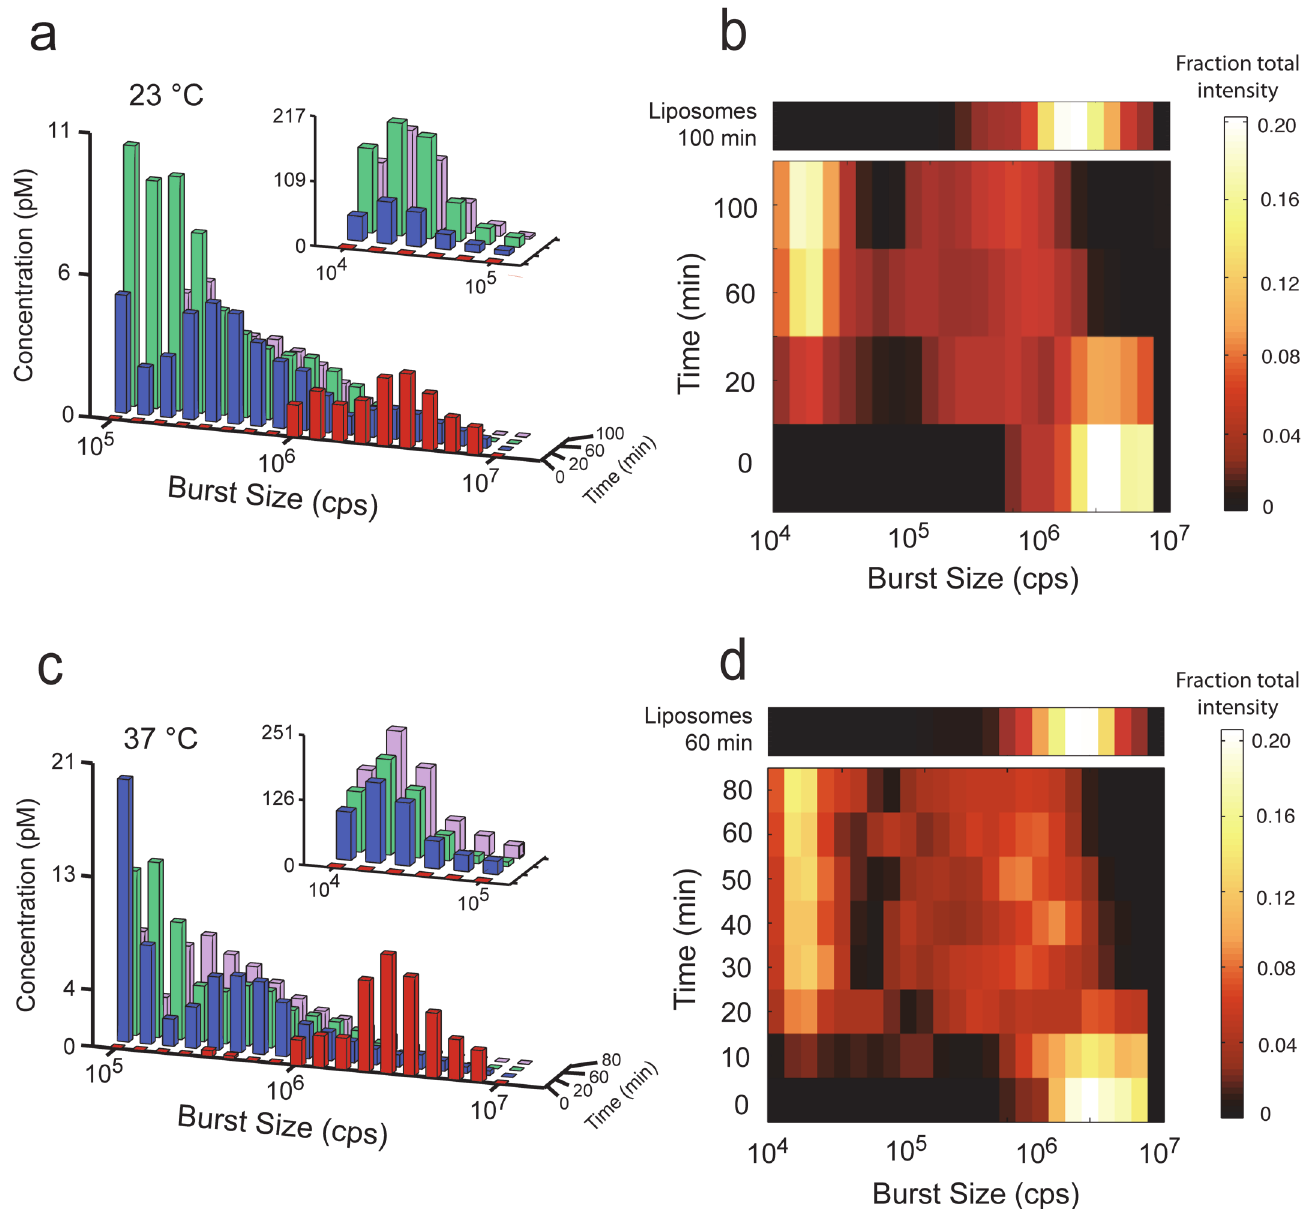
Fig 3. Kinetics of liposome fission are temperature dependent. (a) Histograms of BAS analyzed 200 nm-diameter, TopFluor-labeled, (5%) PtdInsP(4,5) P 2 Folch liposomes ( red ) and products of ENTH incubation at 23°C for 20 ( blue ), 60 ( green ), and 100 min ( purple ) after addition of 2 μ M ENTH. At each time point, an aliquot was removed and placed on ice, and measurements were started within 1 – 2 min. Inset indicates resolution of small particles in a 10-fold dilution of each reaction. (b) Heat map representation of the fractional intensity for each reaction shown in (a). (c) BAS histograms generated from starting liposomes ( red ) and products of ENTH incubation at 37°C for 20 ( blue ), 60 ( green ), and 80 min ( purple ) after addition of 2 μ M ENTH. (d) Heat-map representation of the fractional intensity for each reaction shown in (c). Additional time points are shown, for increased resolution. The effect of incubating liposomes in the absence of the ENTH domain for 60 min at 37°C or 100 min at 23°C is shown as an additional row, above the respective heat maps. The data shown for the experiments conducted at 23°C is representative of four experimental replicates. The data shown for experiments conducted at 37°C is representative of three experimental replicates.